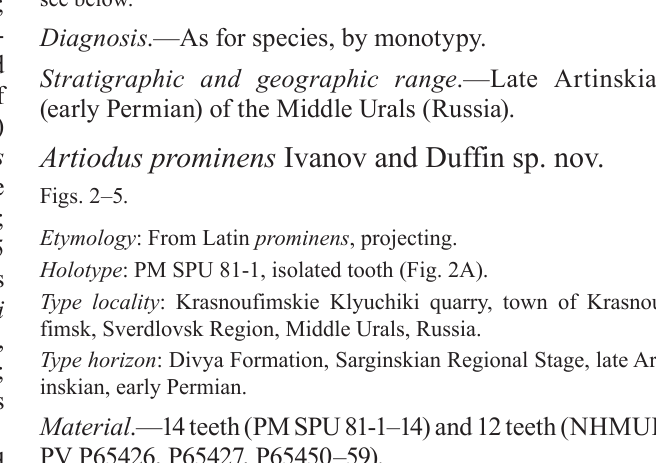
Etymology : From Latin prominens , projecting. Holotype : PM SPU 81-1, isolated tooth (Fig.